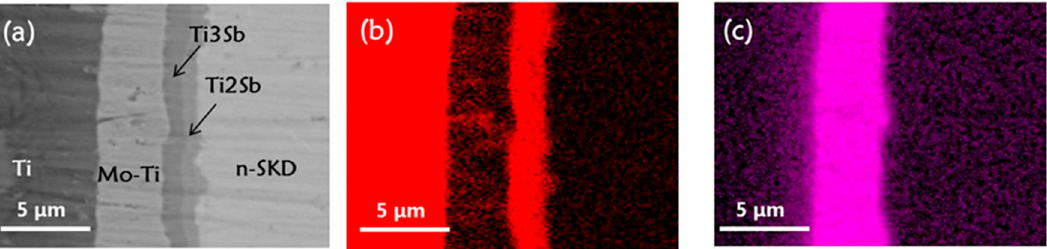
Figure 5. The interfacial microstructure of the pretreated joints isothermally aged at 600 °C for 41 days. ( a ) BSE graph and spot testing, ( b ) distribution of Ti, ( c ) distribution of Mo.